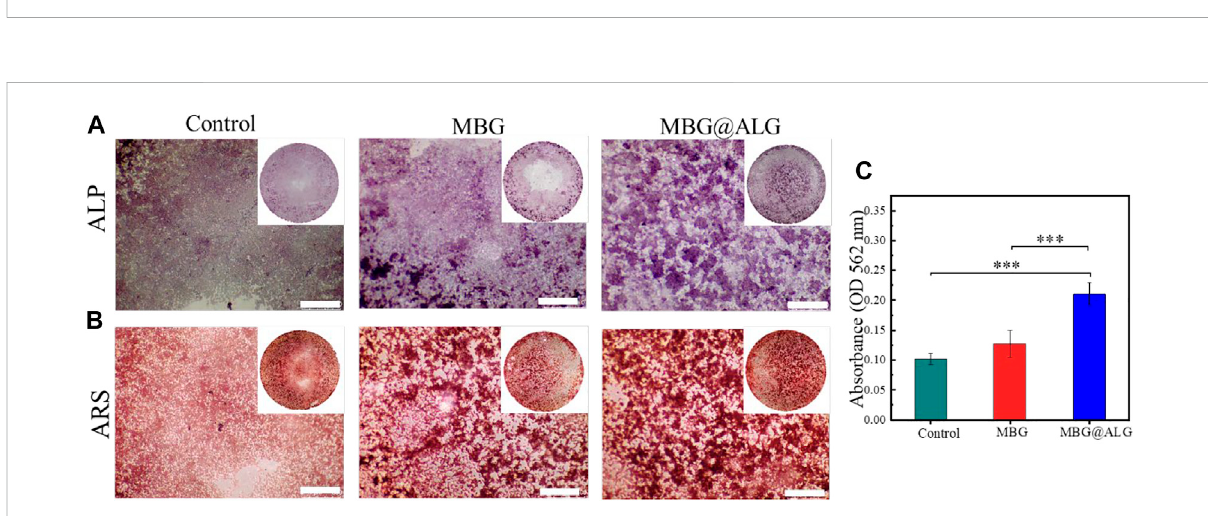
FIGURE 7 (A) Cell viability ofMC3T3-E1 cells after being cocultured with MBG and MBG@ALG. (B) AO/EB staining fl uorescence images ofMC3T3-E1 cells after being cocultured with MBG and MBG@ALG. (Bar = 100 μ m n = 5, * p < 0.05, ** p < 0.01)